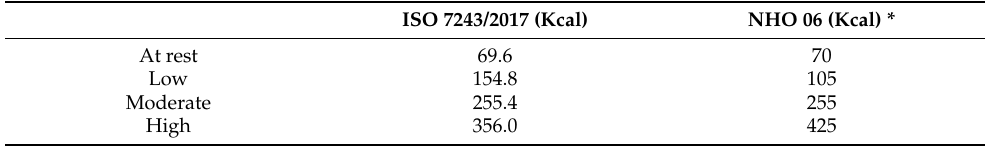
Table 1. Energy consumption per activity